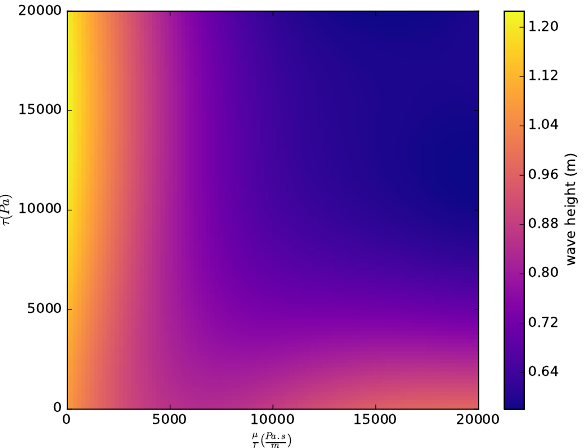
Figure 10. Wave height comparison for yield stress and boundary layer viscosity, with all other parameters at mean